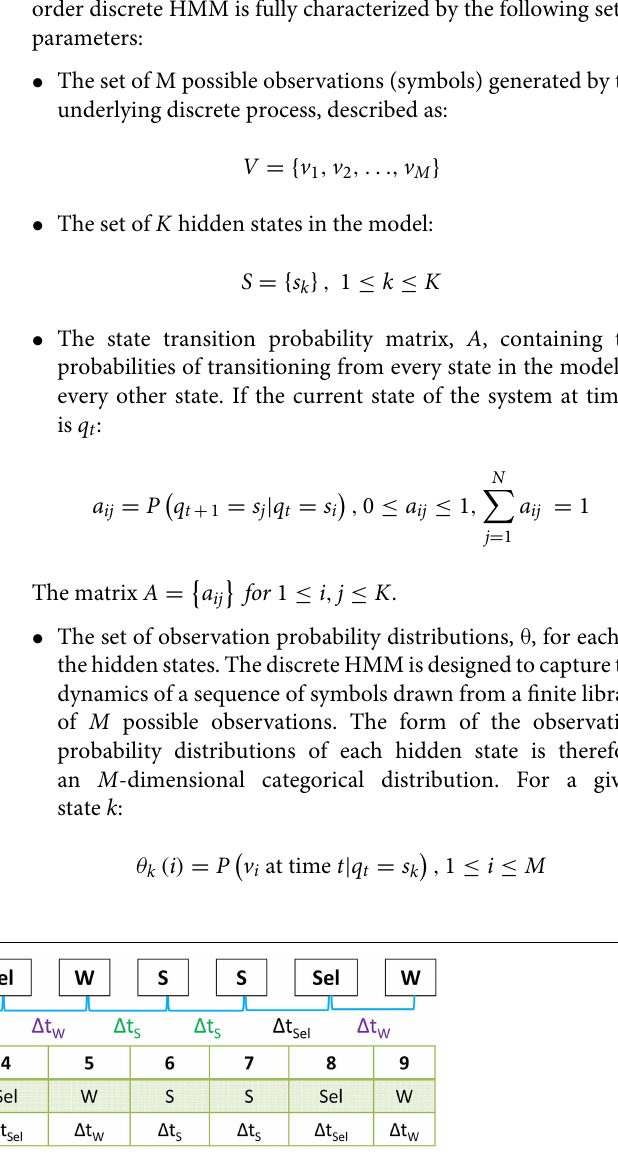
FIGURE 2 | The Wiggle computer game logged the sequence of user activities using 4 behavior codes ( select , swap , reswap , and wiggle ). We derived a second feature from this time series that is representative of the rate at which these behaviors occurred by computing the time delta between activities. At the top of the diagram is an example of a raw data sequence.